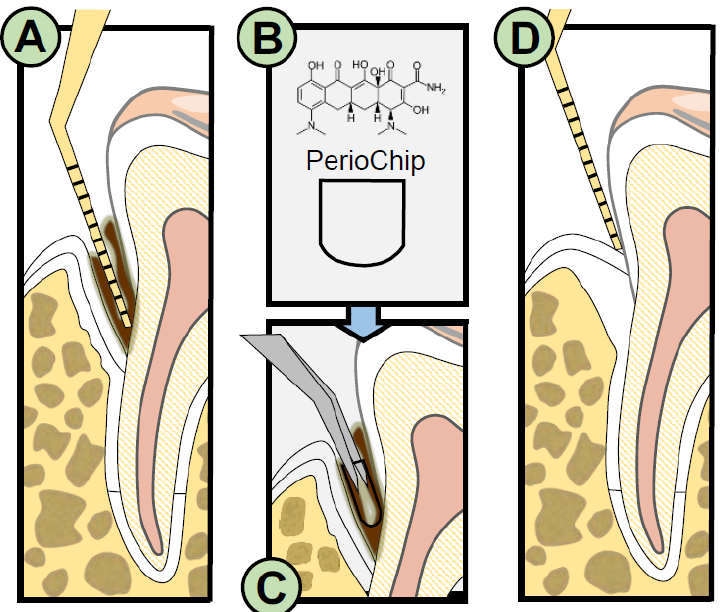
Figure 2. Local delivery treatment with chip containing Chlorhexidine ( A ) after non-surgical peri- odontal debridement to reduce biofilm; ( B ) small chip (4.5 × 3.5 mm 2 ) composed of biodegradable hydrolyzed gelatin matrix, crosslinked with glutaraldehyde, also contains glycerine and water, into which 2.5 mg Chlorhexidine Gluconate is incorporated; ( C ) Perio Chip inserted into periodontal pocket; ( D ) improvement in PD and CAL with Perio Chip as an adjunct to SRP.